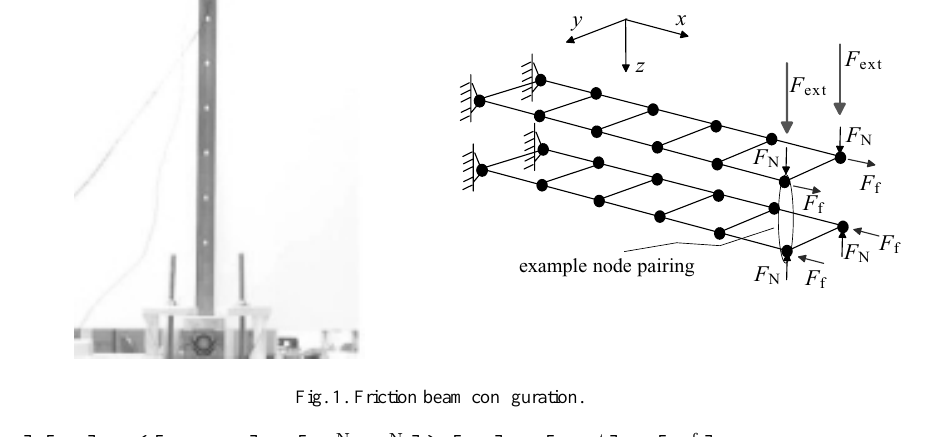
Fig. 1. Friction beam